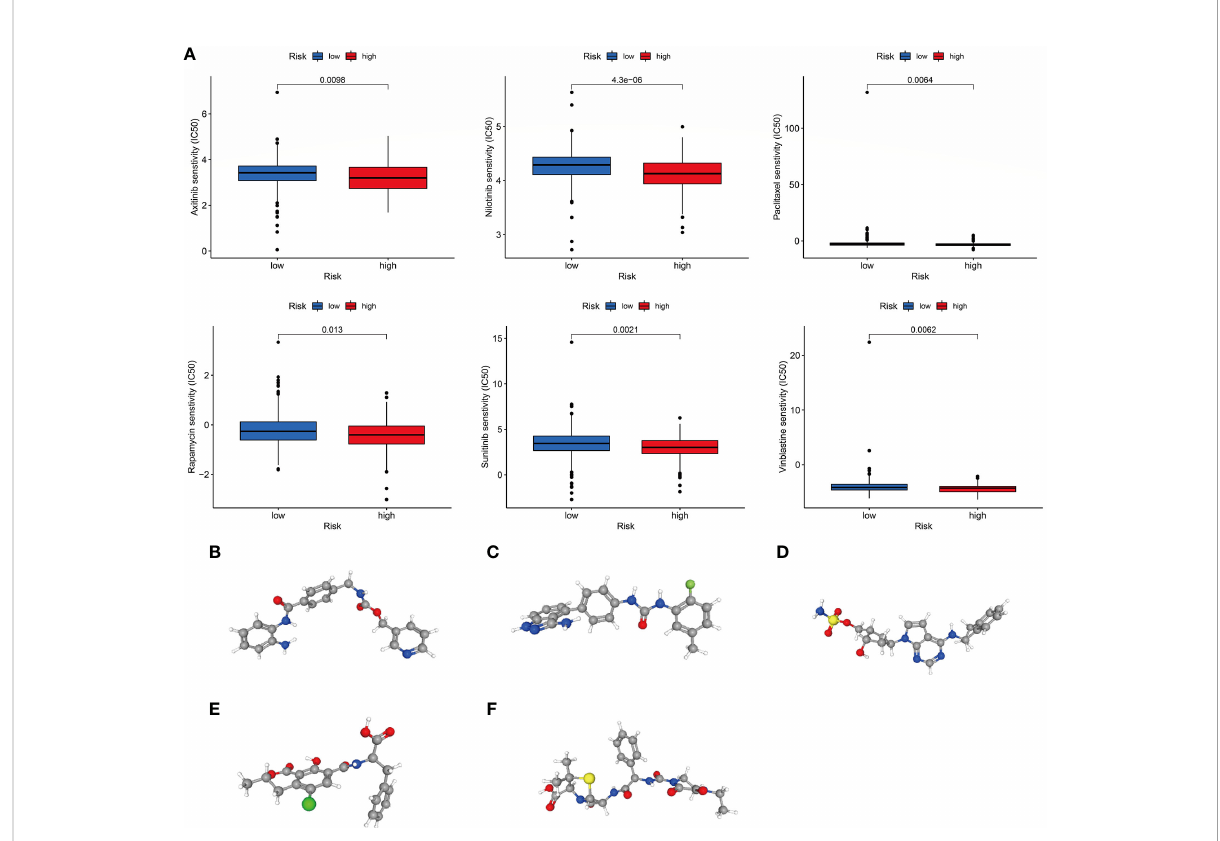
FIGURE 11 Correlation of the choline metabolism-related signature with chemotherapy response. (A) Sensitivity analysis of high- and low-risk patients to six common chemotherapeutic drugs. (B – F) 3D structures of small molecule drugs predicted by the PubChem open chemical database, including entinostat (B) , linifanib (C) , MLN-4924 (D) , ochratoxin-a (E) , and piperacillin (F)